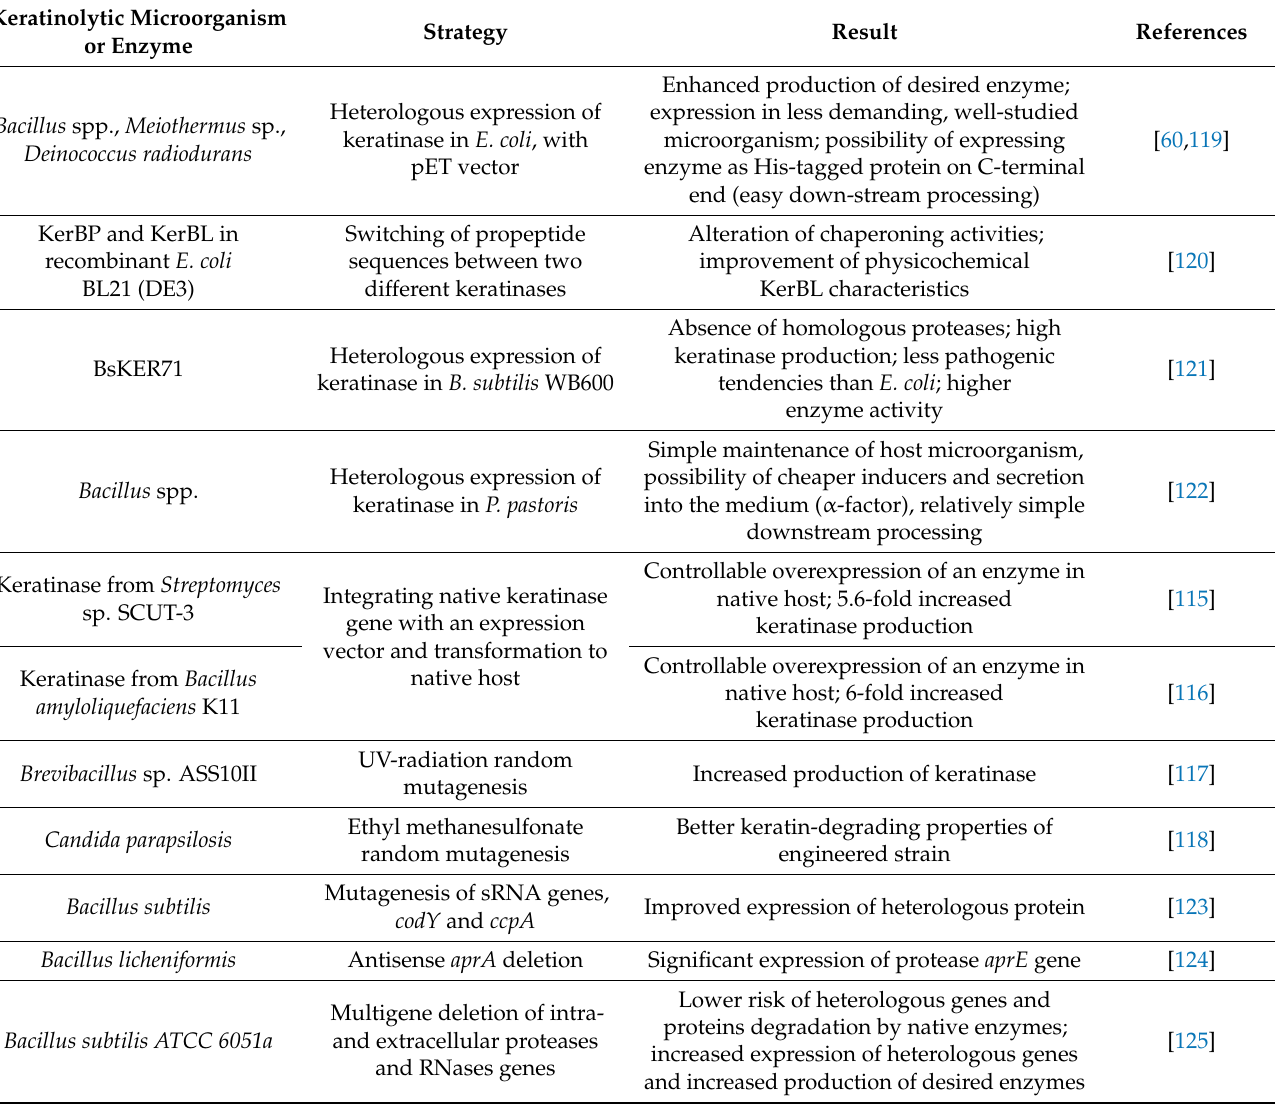
Table 5. Chosen examples of engineering strategies for keratinolytic strain and/or enzyme